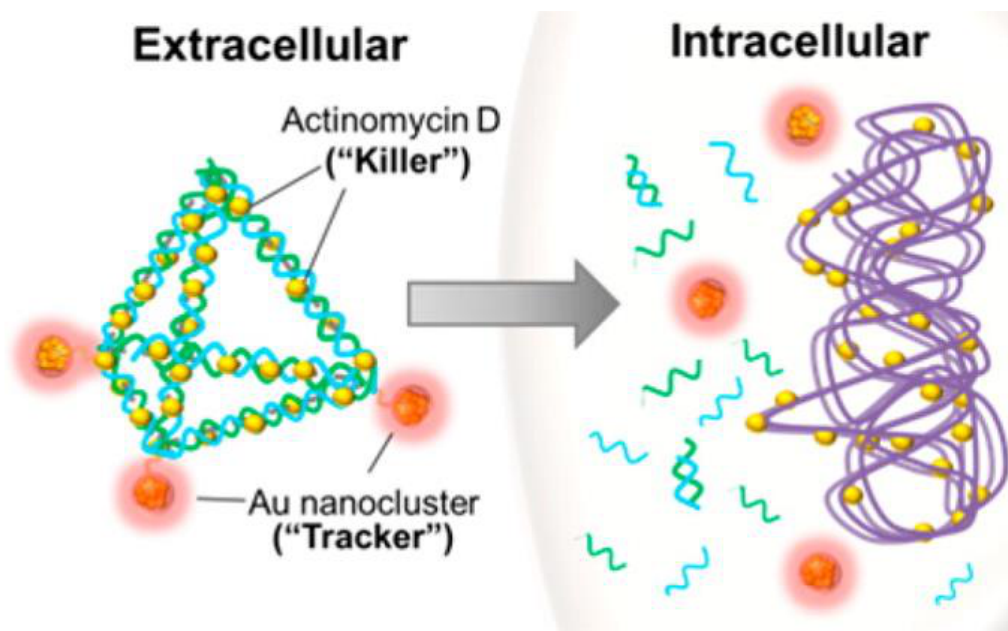
Figure 2. Representative scheme of DPAu/AMD as a nanotheranostic agent. Reproduced with permission from Reference [72]. Copyright © 2014, American Chemical Society.